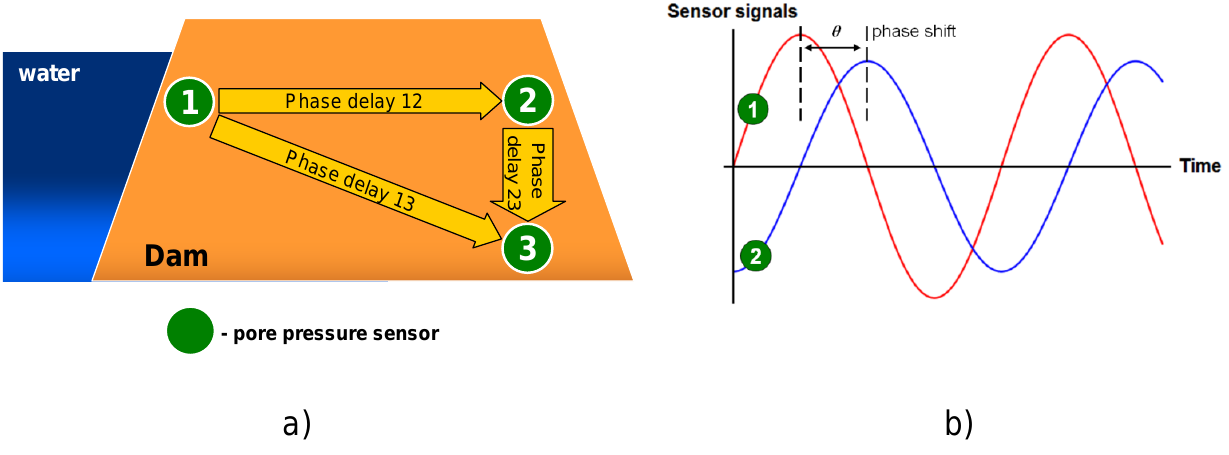
Figure 6. Levee health monitoring based on pairwise phase shift monitoring. ( a ) A scheme of the monitored levee (filled with permeable soil) and sensor positions. ( b ) Illustration of the phase shift concept: pressure wave caused by the sea tides is reaching sensor #2 with a time delay compared to sensor #1 located close to the river. This time lag is called ―phase shift‖ or ―phase delay‖ in signal